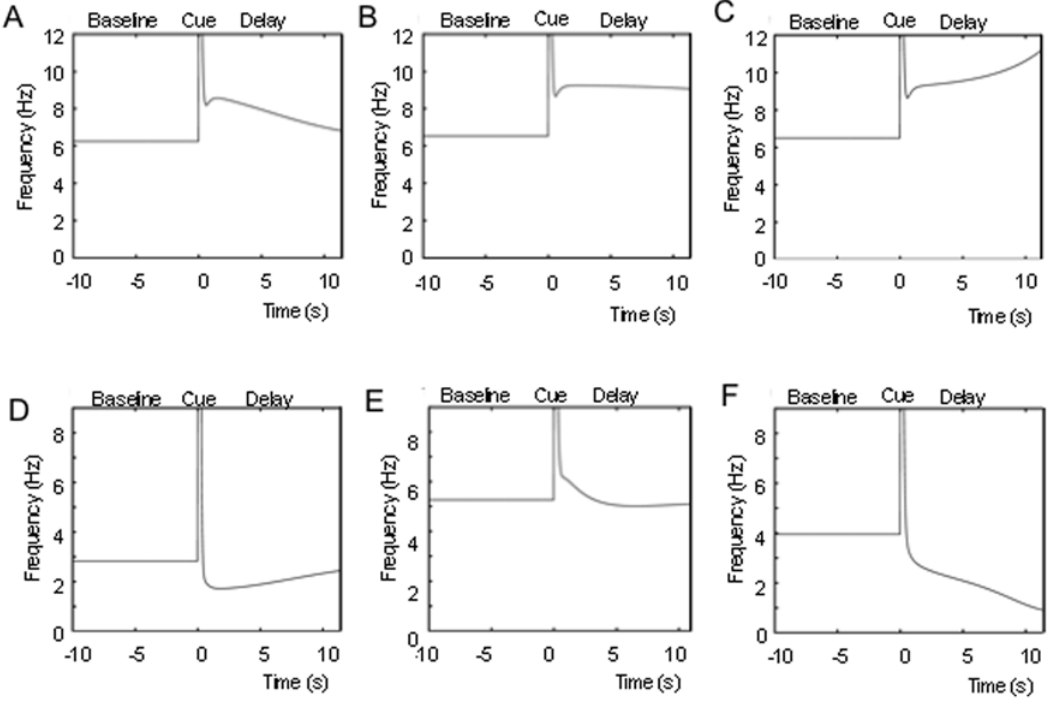
Figure 5. PSTH histograms of activity exhibited by the 2-population firing rate model at different values of the inter-area connectivity. All general patterns in the cortical data as reported in [5] are exhibited by the network, with frequencies in the range of the real data. Firing pattern behaviors shown are A) decaying memory cell, B) Stable memory cell, C) Set cell D) Decaying inhibition cell, E) Stable inhibition cell, and F) ramping inhibition